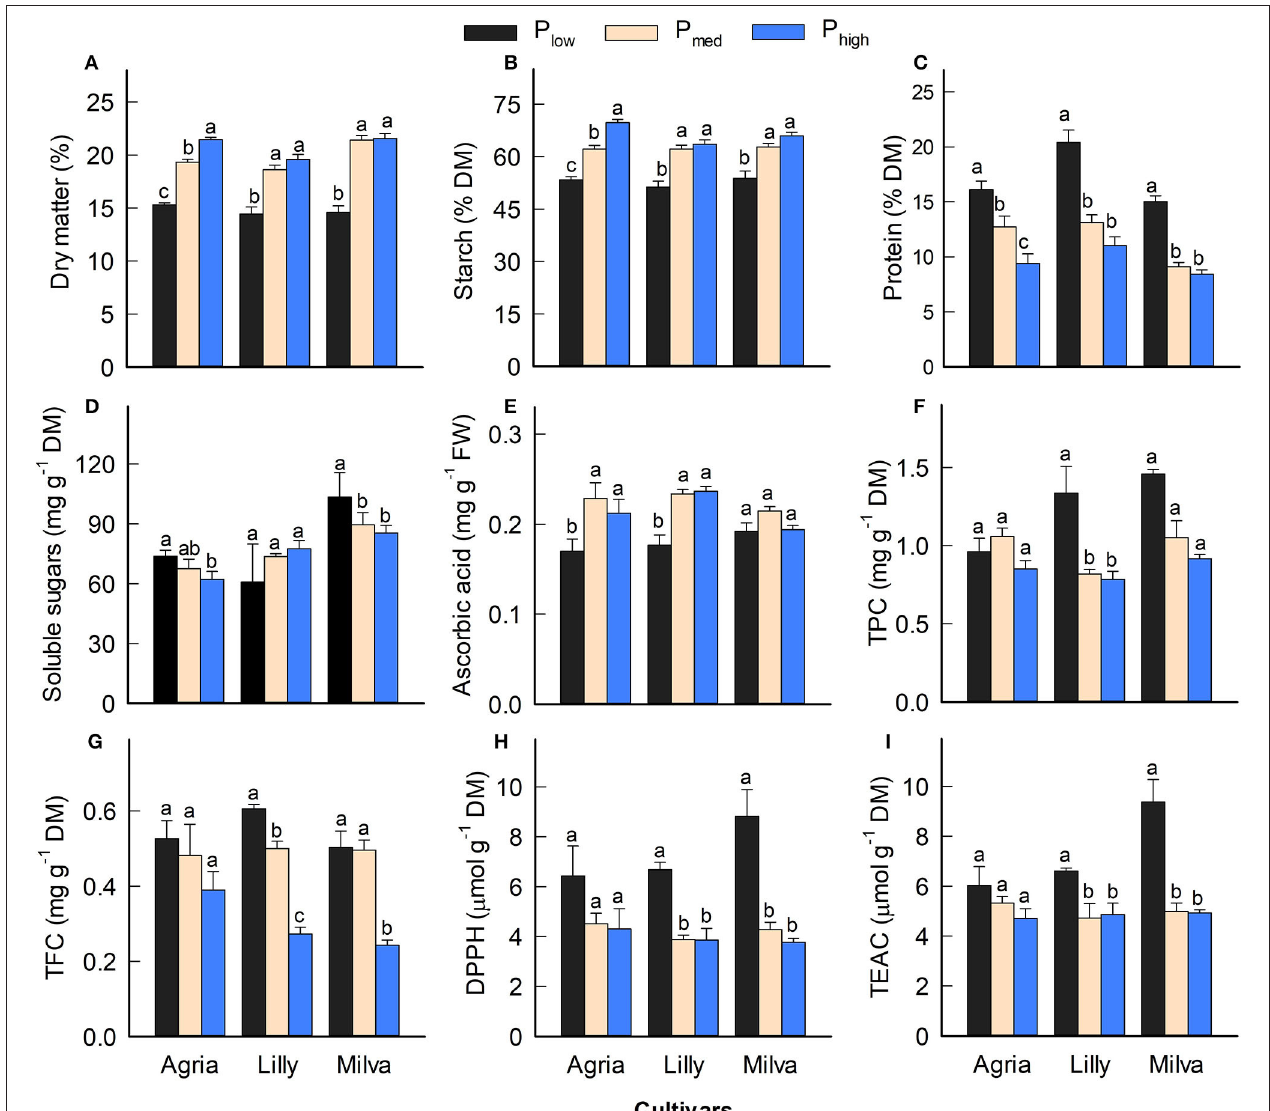
FIGURE 7 | (A–I) Tuber quality characteristics of potato cultivars with the application of P low , P med , and P high . Different letters in lowercase indicate a significant difference between P treatments of each cultivar by Tukey’s HSD test at p < 0.05. DM, dry matter; FW, fresh weight; TPC, total phenolic concentration; TFC, total flavonoid concentration; DPPH, antioxidant capacity by 2,2-diphenyl-1-picrylhydrazyl assay; TEAC, Trolox equivalent antioxidant